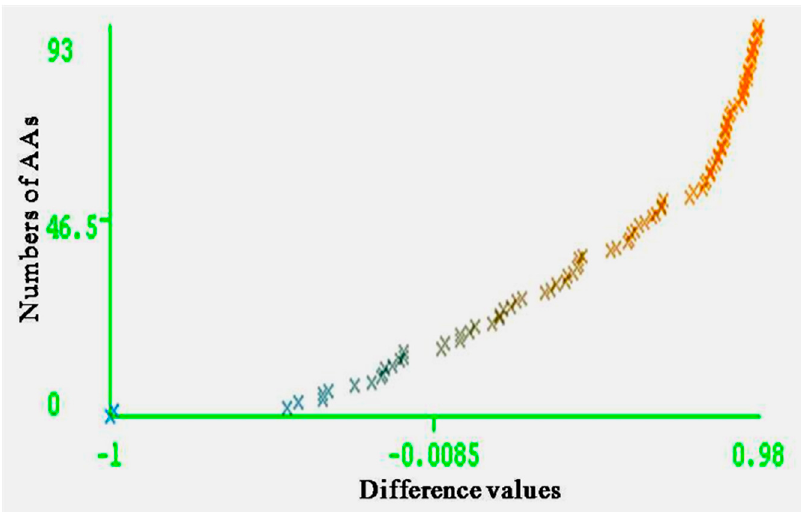
Figure 4. Curve margin of training set. The vertical axes represent the numbers of AAs; the horizontal axes represent the difference values of forecasting probability of actual categories, and the maximum prediction probability of wrong categories.